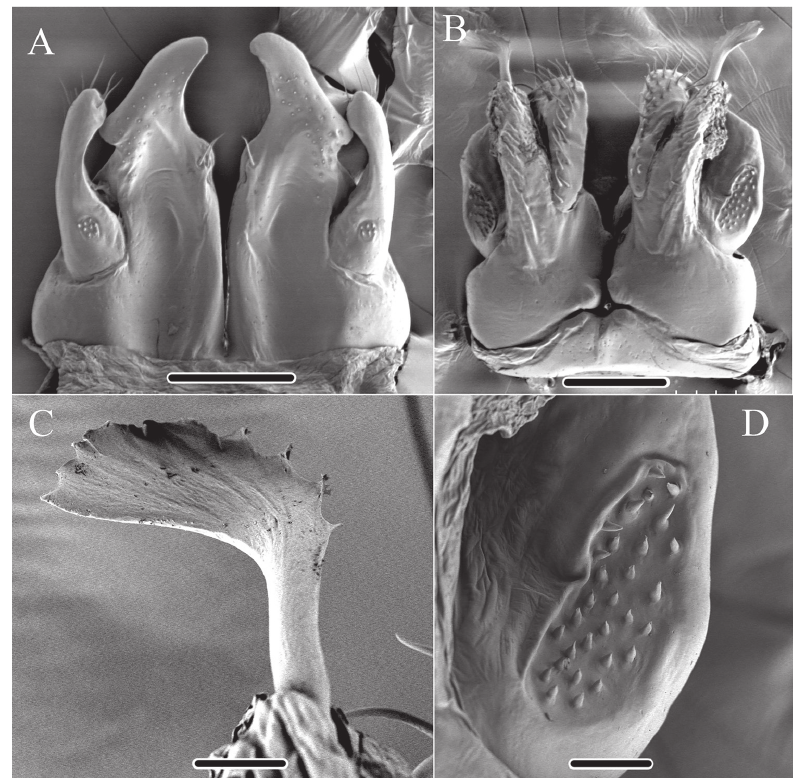
Figure 10. Glyphiulus calceus sp. n., paratype. A anterior gonopods, caudal view B posterior gonopods, caudal view C flagellum of posterior gonopods D microsetae at lateral margin of posterior gonopods. Scale bars: A 0.2 mm B 0.15 mm C 0.025 mm D 0.03